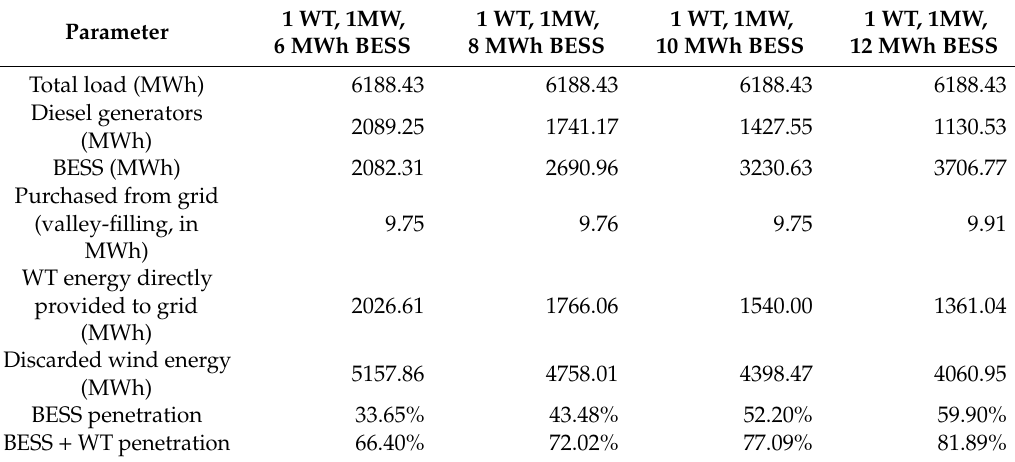
Table 2. Annual electricity production and consumption for Astypalaia